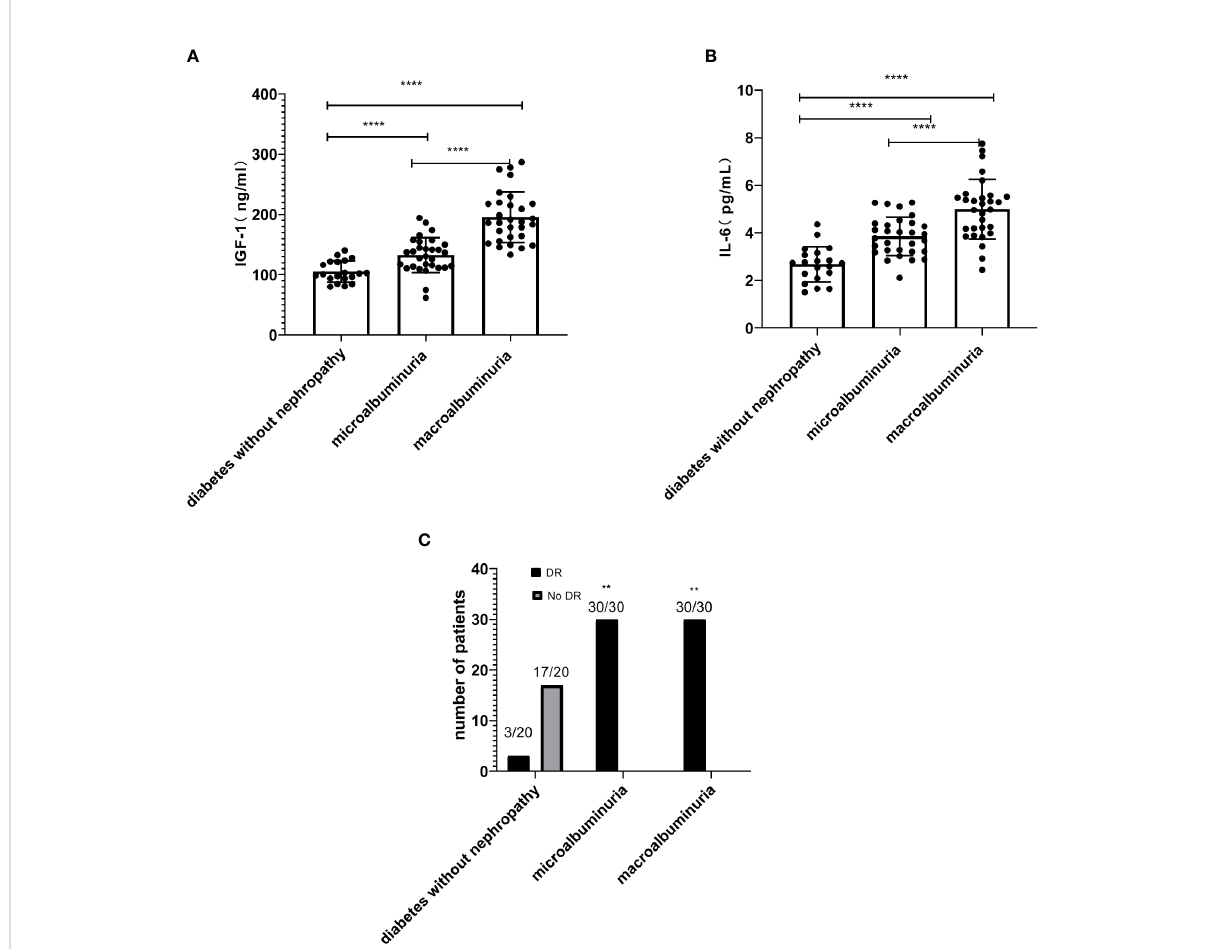
FIGURE 2 The levels of insulin-like growth factor-1 (IGF-1) (A) and interleukin-6 (IL-6) (B) increased with the increase of urinary albumin/creatinine ratio (ACR) in diabetic kidney disease (DKD) patients (**** P < 0.0001). (C) The number of DKD patients with DR is higher than the diabetes without nephropathy group (** P <